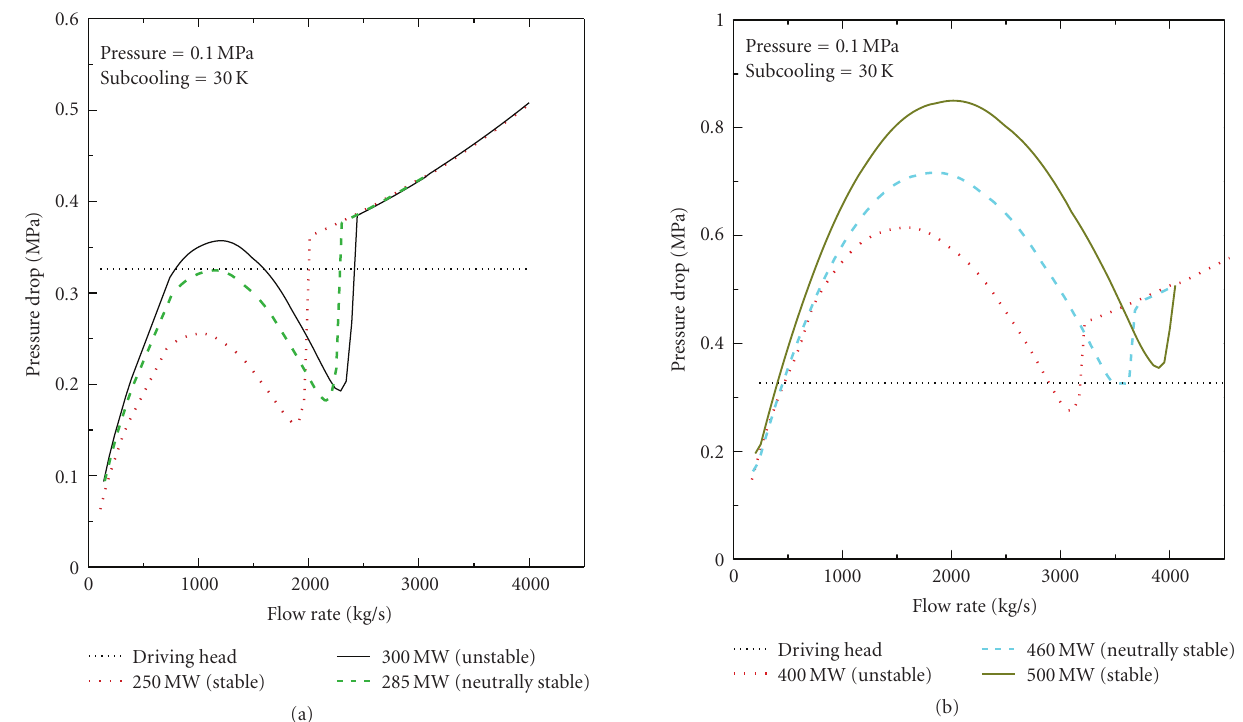
Figure 1: Typical stable, unstable, and neutrally stable behaviour for Ledinegg-type